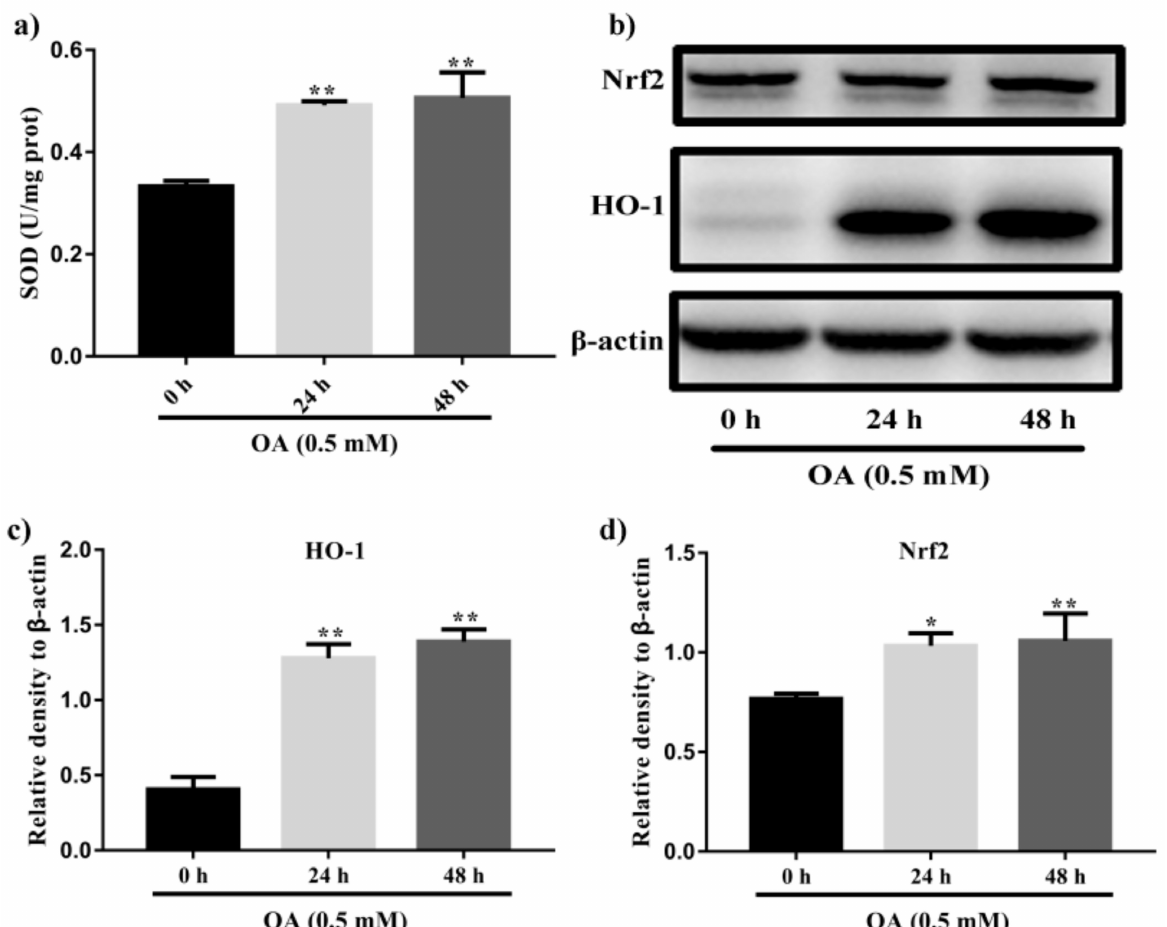
Figure 2. Induction of steatosis by OA in HepG2 cells. ( a ) Measurement of levels of SOD in HepG2 cells after incubation with 0.5 mM OA for 24 h and 48 h. ( b ) Western blot analysis of expression of Nrf2 and HO-1 in HepG2 cells after treatment with 0.5 mM OA for 24 h and 48 h. ( c ) Quantification results of the expression of HO-1. ( d ) Quantification results of the expression of Nrf2. Data were expressed as Mean ± SD of three independent experiments ( n = 3). * p < 0.05 and ** p < 0.01, compared with HepG2 cells without OA treatment (0